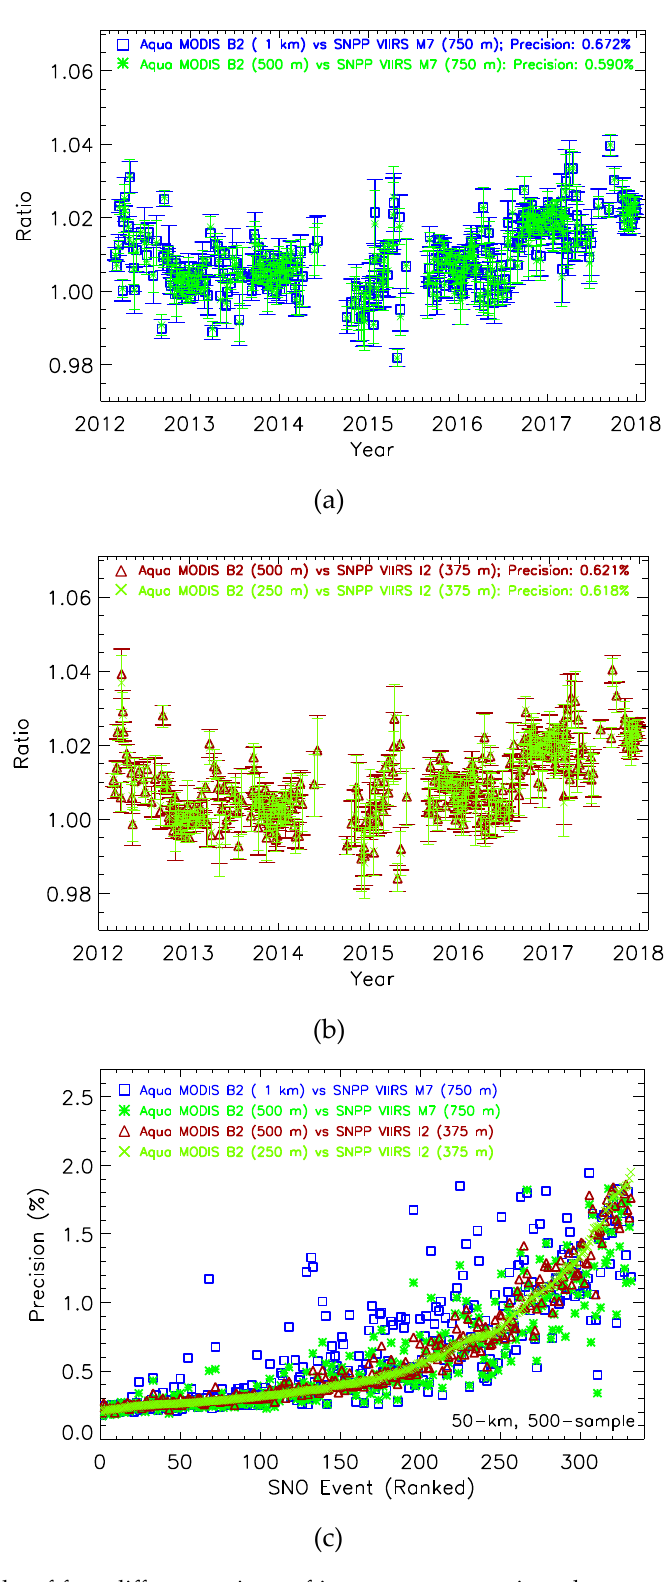
Figure 18. Results of four different regimes of intersensor comparison demonstrated by ( a ) Aqua MODIS B2 versus SNPP VIIRS M7 time series at the 1-km and 750-m regimes, ( b ) Aqua MODIS B2 versus SNPP VIIRS I2 time series at the 500-m and 375-m regimes, and ( c ) the precision versus ranked SNO events for all four cases.